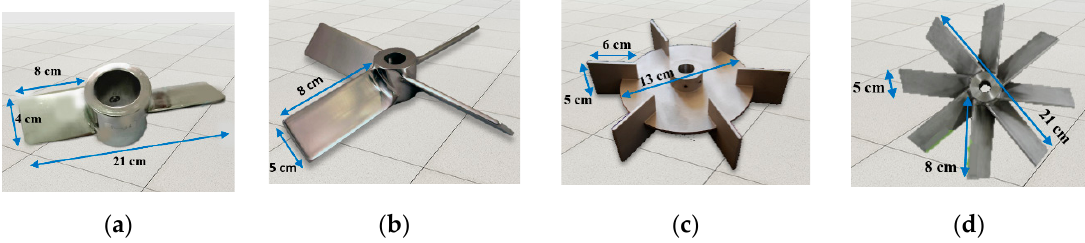
Figure 3. Geometry of the four types of impeller including ( a ) a two-pitched blade turbine, ( b ) a four-pitched blade turbine, ( c ) a Rushton turbine, and ( d ) an eight-pitched blade turbine.